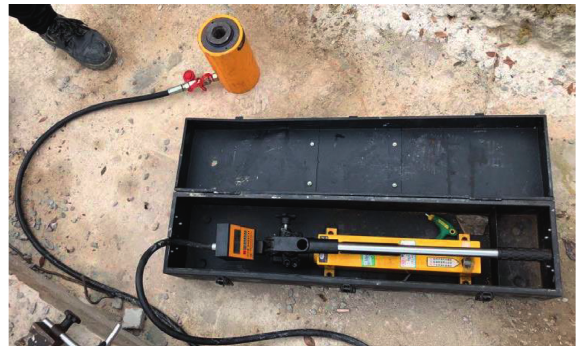
Figure 14: Hydraulic jack bolt drawing equipment.